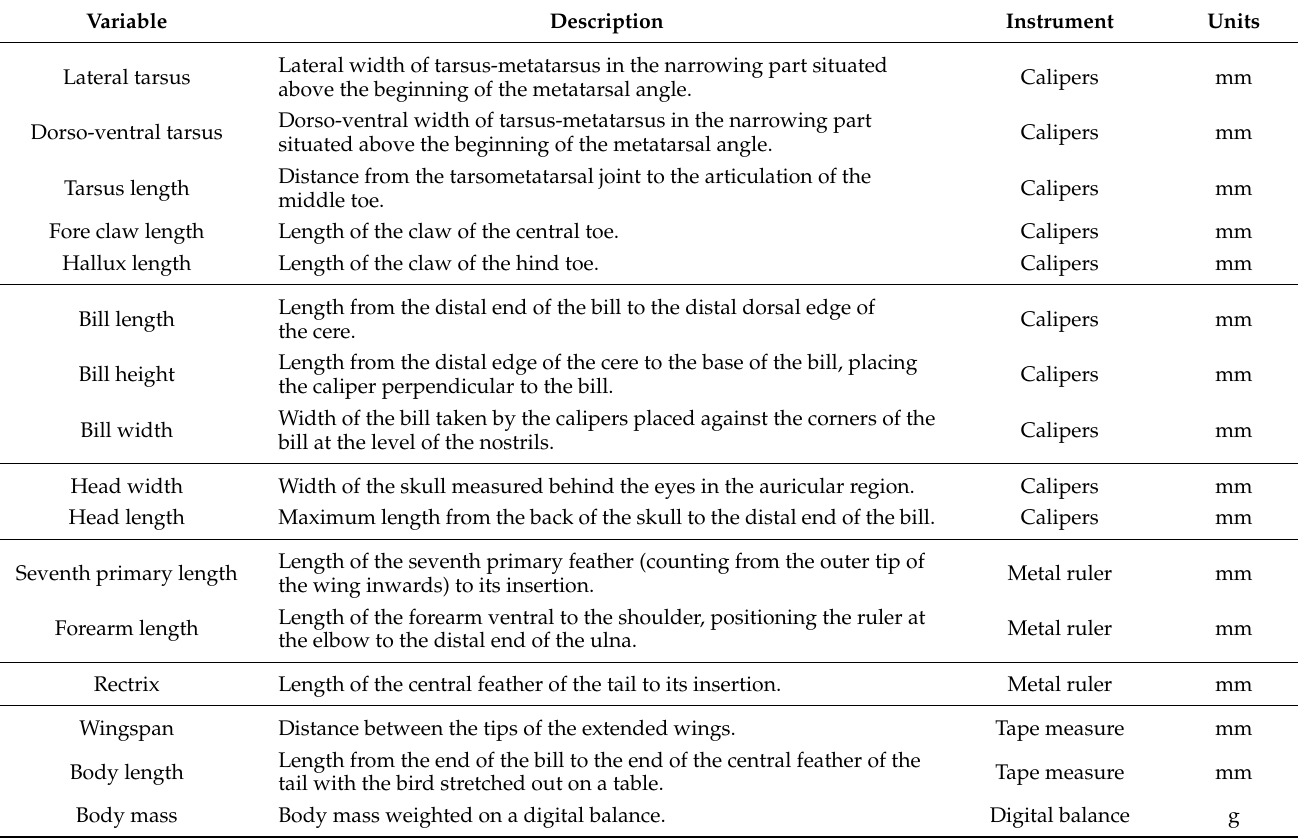
Table 1. Measurements taken from adult and juvenile Bonelli’s eagles in eastern Spain in